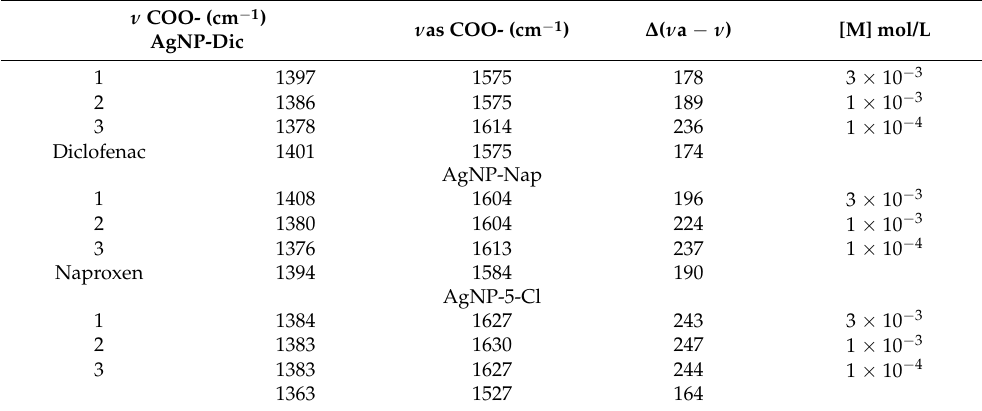
Table 2. Infrared frequency values of the symmetric and asymmetric stretching of the carboxylate